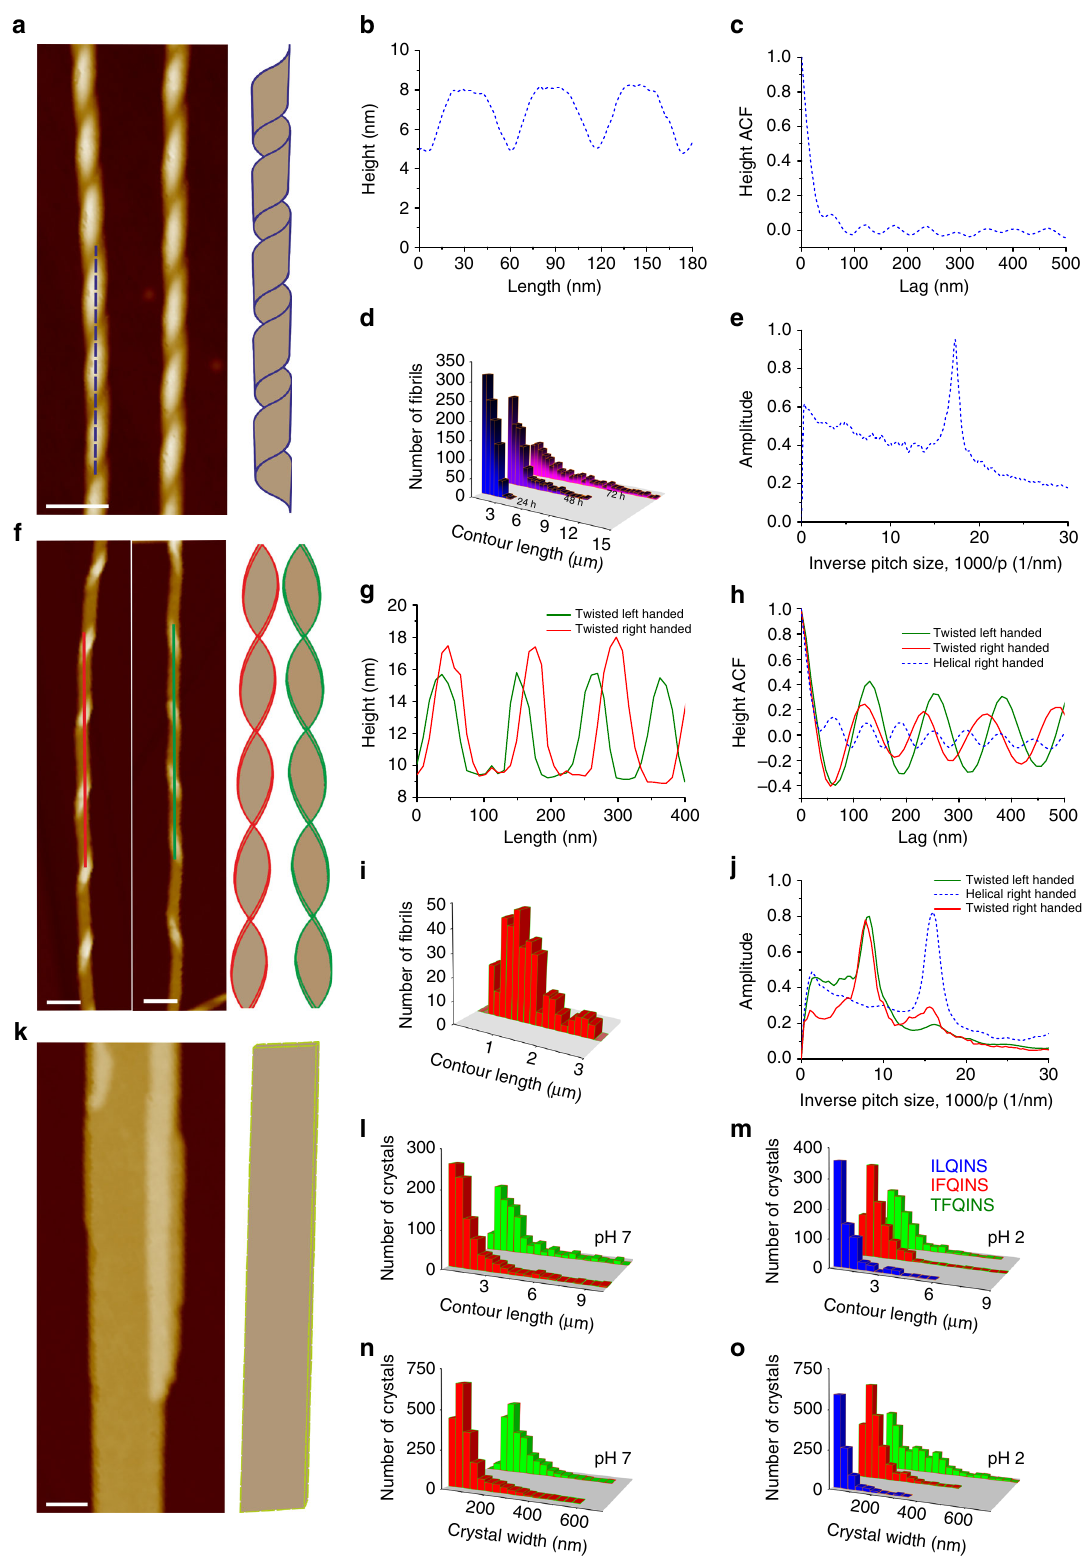
Fig. 2 Statistical analysis of helical fi brils, twisted fi brils and crystals. a – e Helical fi brils from ILQINS, f – j twisted fi brils of IFQINS and k – o crystals of all three peptides. AFM height images a , f , k (scale bar = 50 nm, Z -scale = 20 nm) with corresponding height pro fi les b , g . Contour length distribution of fi brils d , i ; estimation of the pitch calculated from the autocorrelation function (ACF) c , h and discrete Fourier transform (DFT) e , j . Statistical analysis of TEM data sets (~1000 crystals) showing the distribution of crystal contour lengths l , m and widths n , o at pH 2 and pH